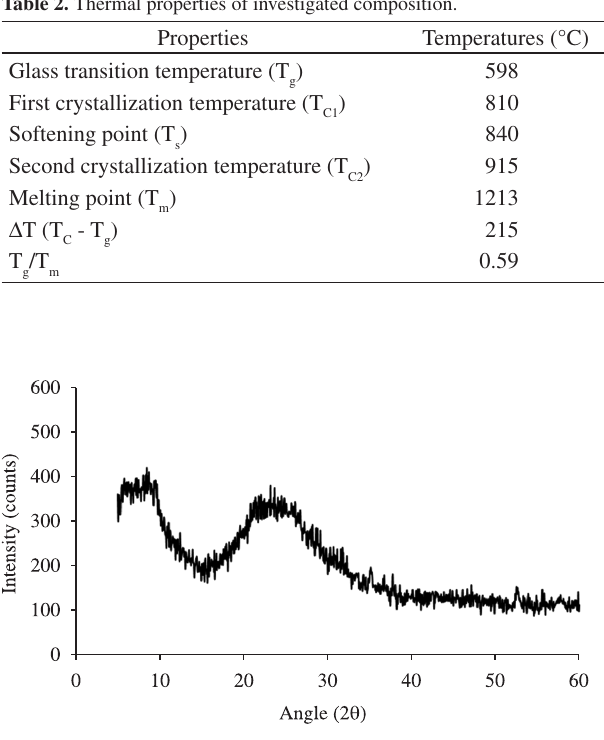
Figure 1. X ray diffraction patterns for the glass at room